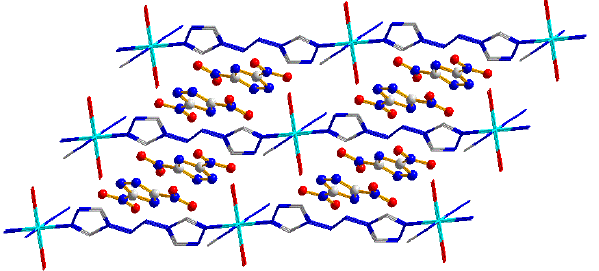
Figure 4. Structure of metal–organic frameworks (MOFs, DNT) with anion in the